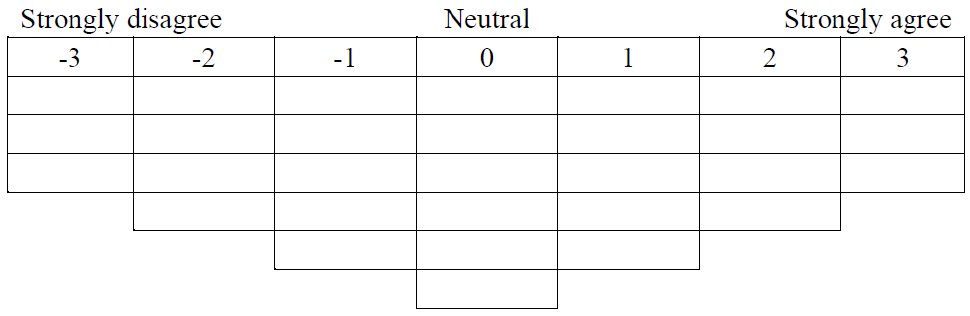
Figure 3. The structure distribution of the Q scale (N = 30).